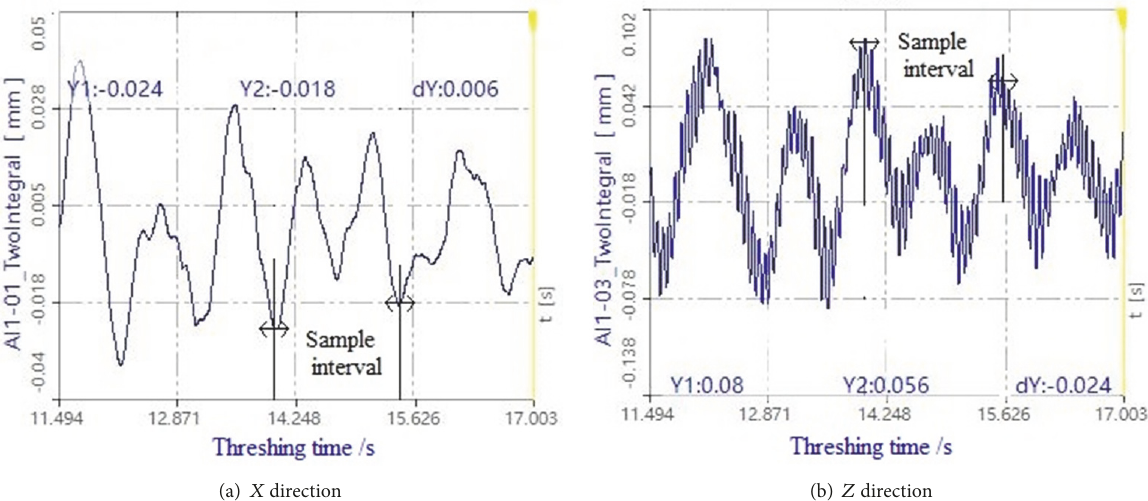
Figure 14: Typical vibration waveform of no-load cylinder rotation.